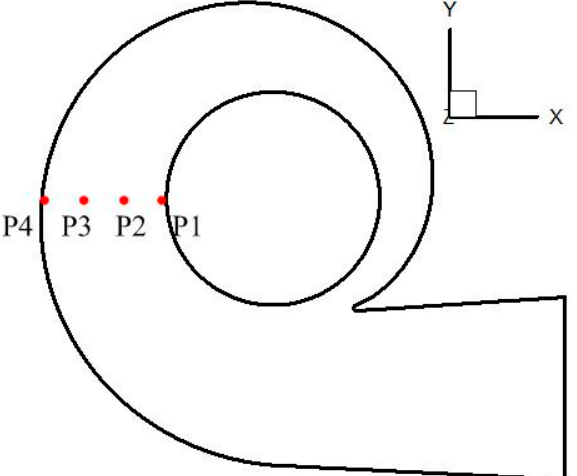
Figure 11. Monitoring points in volute at mid-span of centrifugal pump.